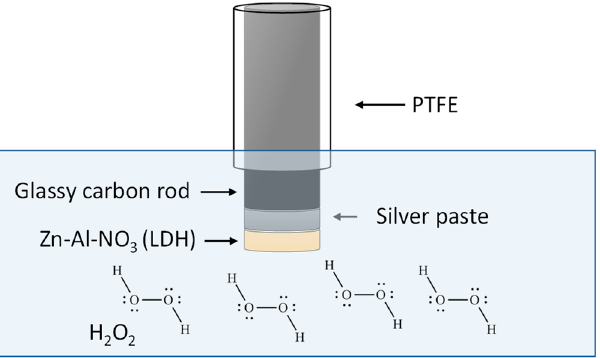
Figure 2. Schematic diagram of the GC-Ag (paste) -LDH-H 2 O 2 catalytic sensor used in this work.